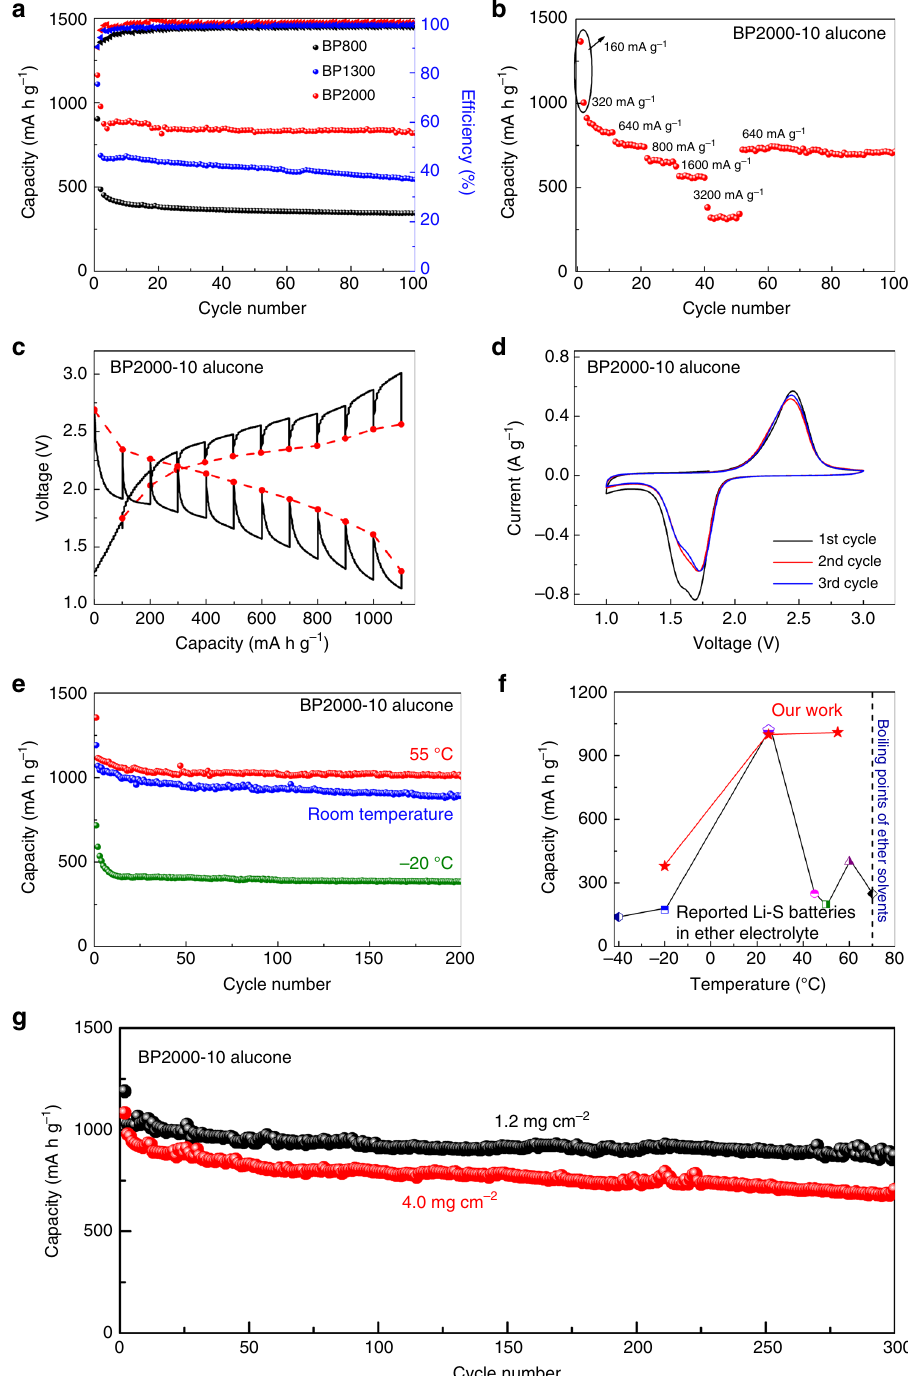
Fig. 4 Optimization of carbon hosts for sulfur cathodes in carbonate lithium – sulfur cells. a Cycle performance of 10-cycle alucone-coated C – S electrodes with different carbon hosts at a current density of 320 mA g − 1 . b – g Electrochemical characterizations of 10-cycle alucone-coated sulfur cathodes with BP2000 as carbon hosts (BP2000-10 alucone): b rate performance, c equilibrium voltage (red dashed lines) and transient voltage (black solid lines) pro fi le vs. capacity, d cyclic voltammogram, e cycle performance operating at various temperatures, f comparison of reported Li – S cells and our work at various temperatures (Supplementary Table 3), and g long cycling performance of alucone-coated C – S electrodes with various sulfur